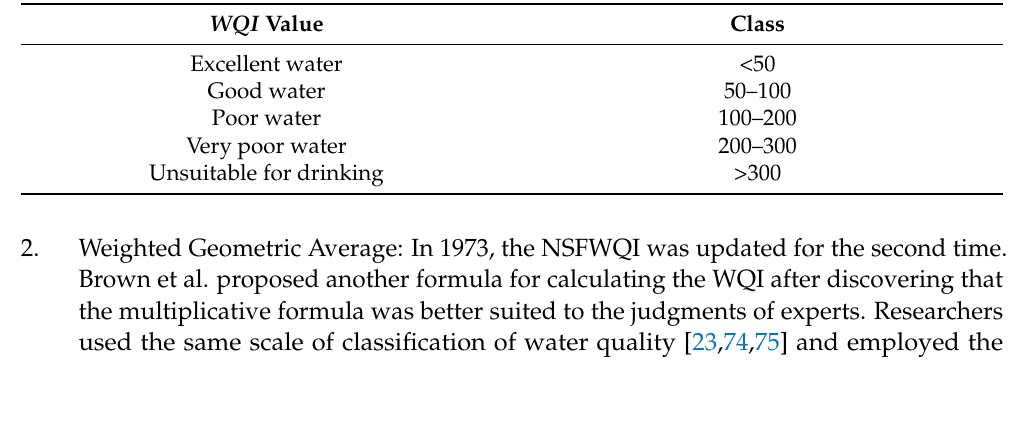
Table 5. Classification of water quality